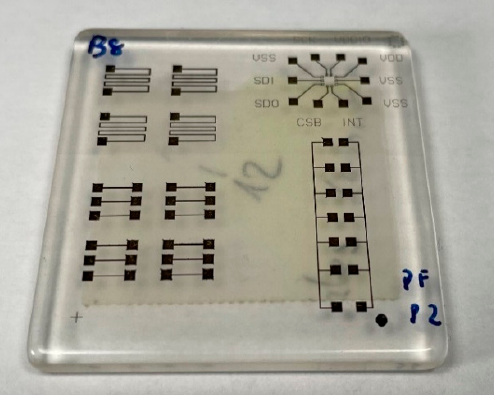
Figure 1. Typical test layouts on 2D test substrates (Luxaprint 3D mold, substrate dimension 40 × 40 mm 2 ).